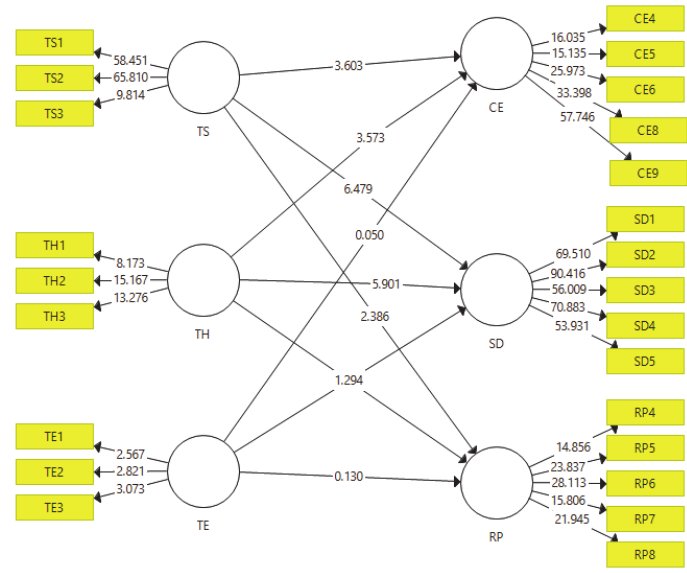
Fig. 3. Teleworking and Burnout Modeling